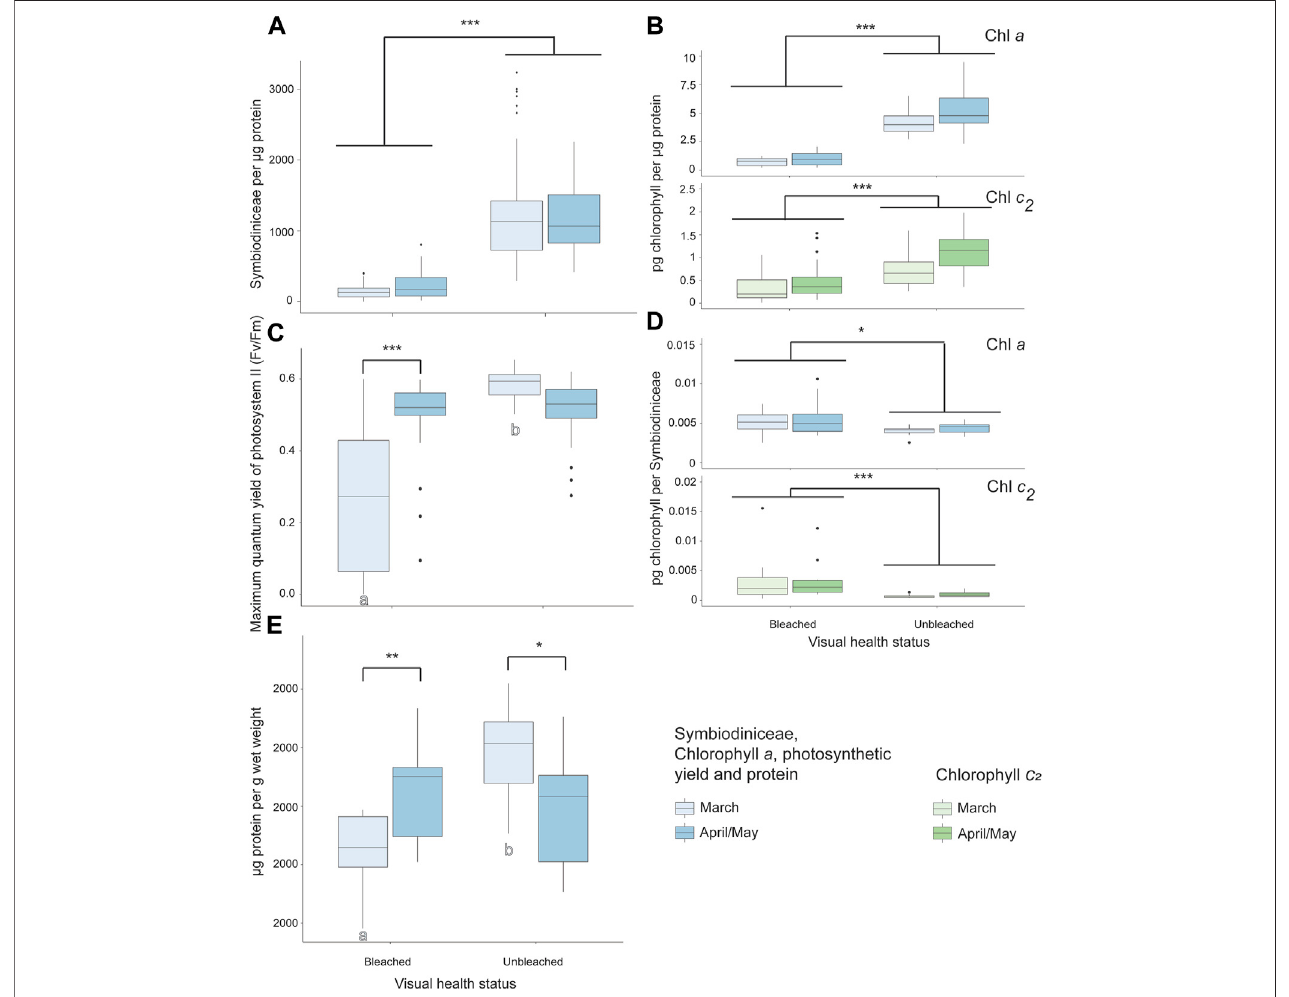
FIGURE 5 | Bleaching responses to a marine heat wave in Cladiella sp. 1 at Sylphs Hole Reef in Lord Howe Island lagoon. (A) Symbiodiniaceae density per µg protein in visually bleached and healthy Cladiella sp. 1 colonies during March and April/May. (B) Chlorophyll a (above) and c 2 (below) densities per µg protein in visually bleachedandhealthyCladiella sp.1coloniesduringMarch andApril/May. (C) PSIIphotochemistryofvisuallybleachedandhealthy Cladiella sp.1coloniesduringMarch and April/May. (D) Chlorophyll a (above) and c 2 (below) per Symbiodiniaceae cell in visually bleached and healthy Cladiella sp. 1 colonies during March and April/ May. (E) µg protein per g wet weight in visually bleached and healthy Cladiella sp. 1 colonies during March and April/May. Signi fi cance is designated either by different letter group or by a bar. p -values are represented as follows — * for p < 0.05, ** for p < 0.005, and *** for p < 0.0005. Where more than one plot is grouped together, the highest p -value is reported. Bars above the boxplots represent monitoring interval differences within health state, and letters below the boxplots represent health state differences within monitoring intervals.